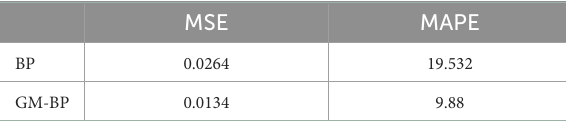
TABLE 2 Comparison of carbon emission (CE) prediction